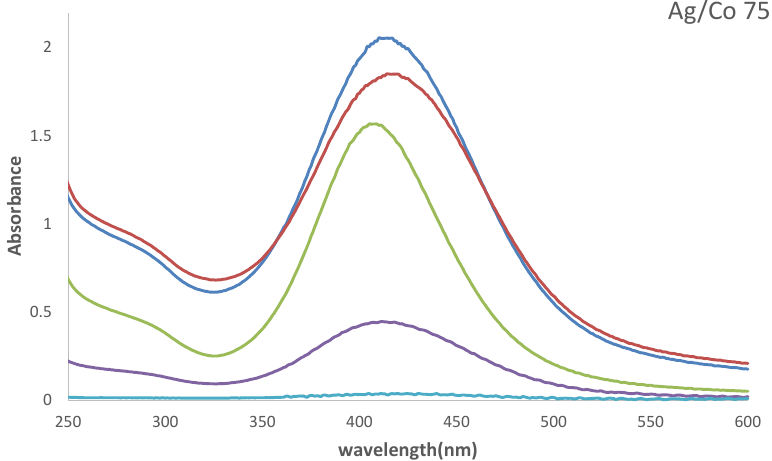
Fig. 4: Absorption spectra of silver-cobalt nanoparticles produced from silver nanoparticles at a different time interval of 75 seconds on the first, second, third, seventh, and fourteenth days (The electrical current adjusted at 1amp and rotational speed was 3000 rpm).